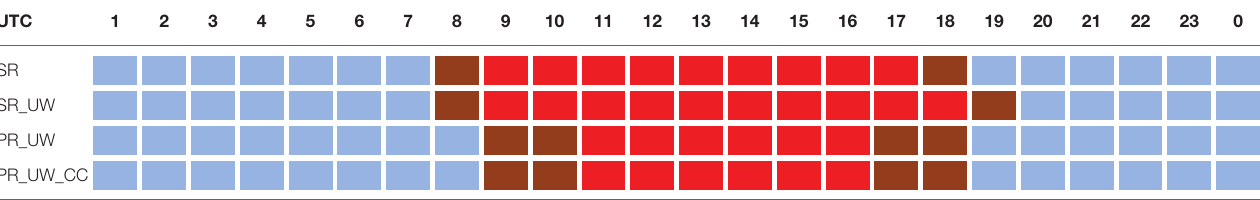
TABLE 2 | Average times of inflow (red), outflow (blue), and transition (brown) phases of Alpine pumping derived from the mean hourly wind fields for the different criteria combinations. UTC